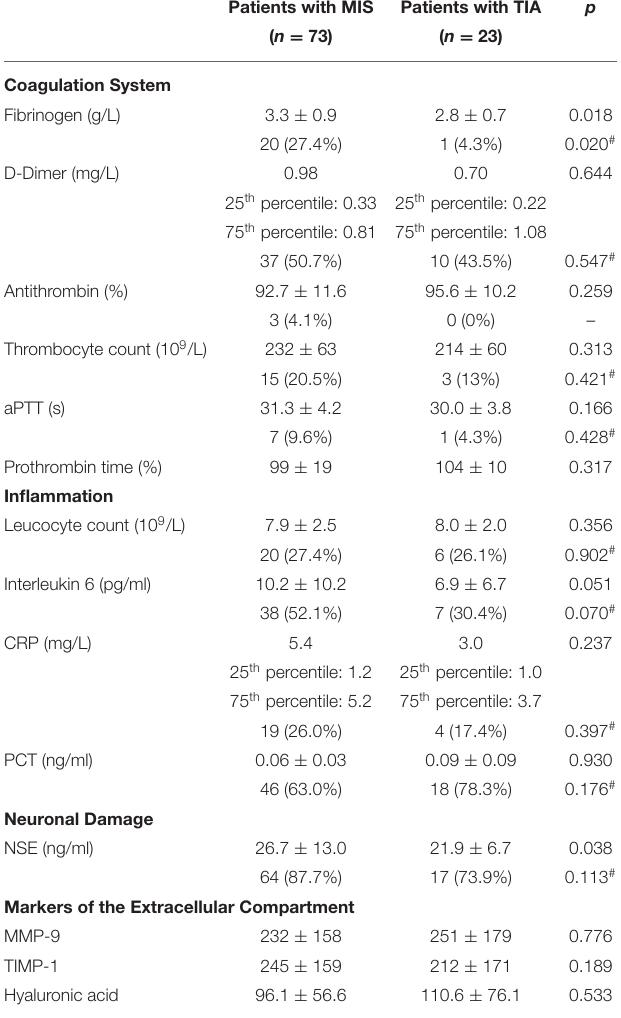
TABLE 3 | Comparison of biomarkers between patients with minor ischemic stroke and transient ischemic attack. Patients with MIS Patients with